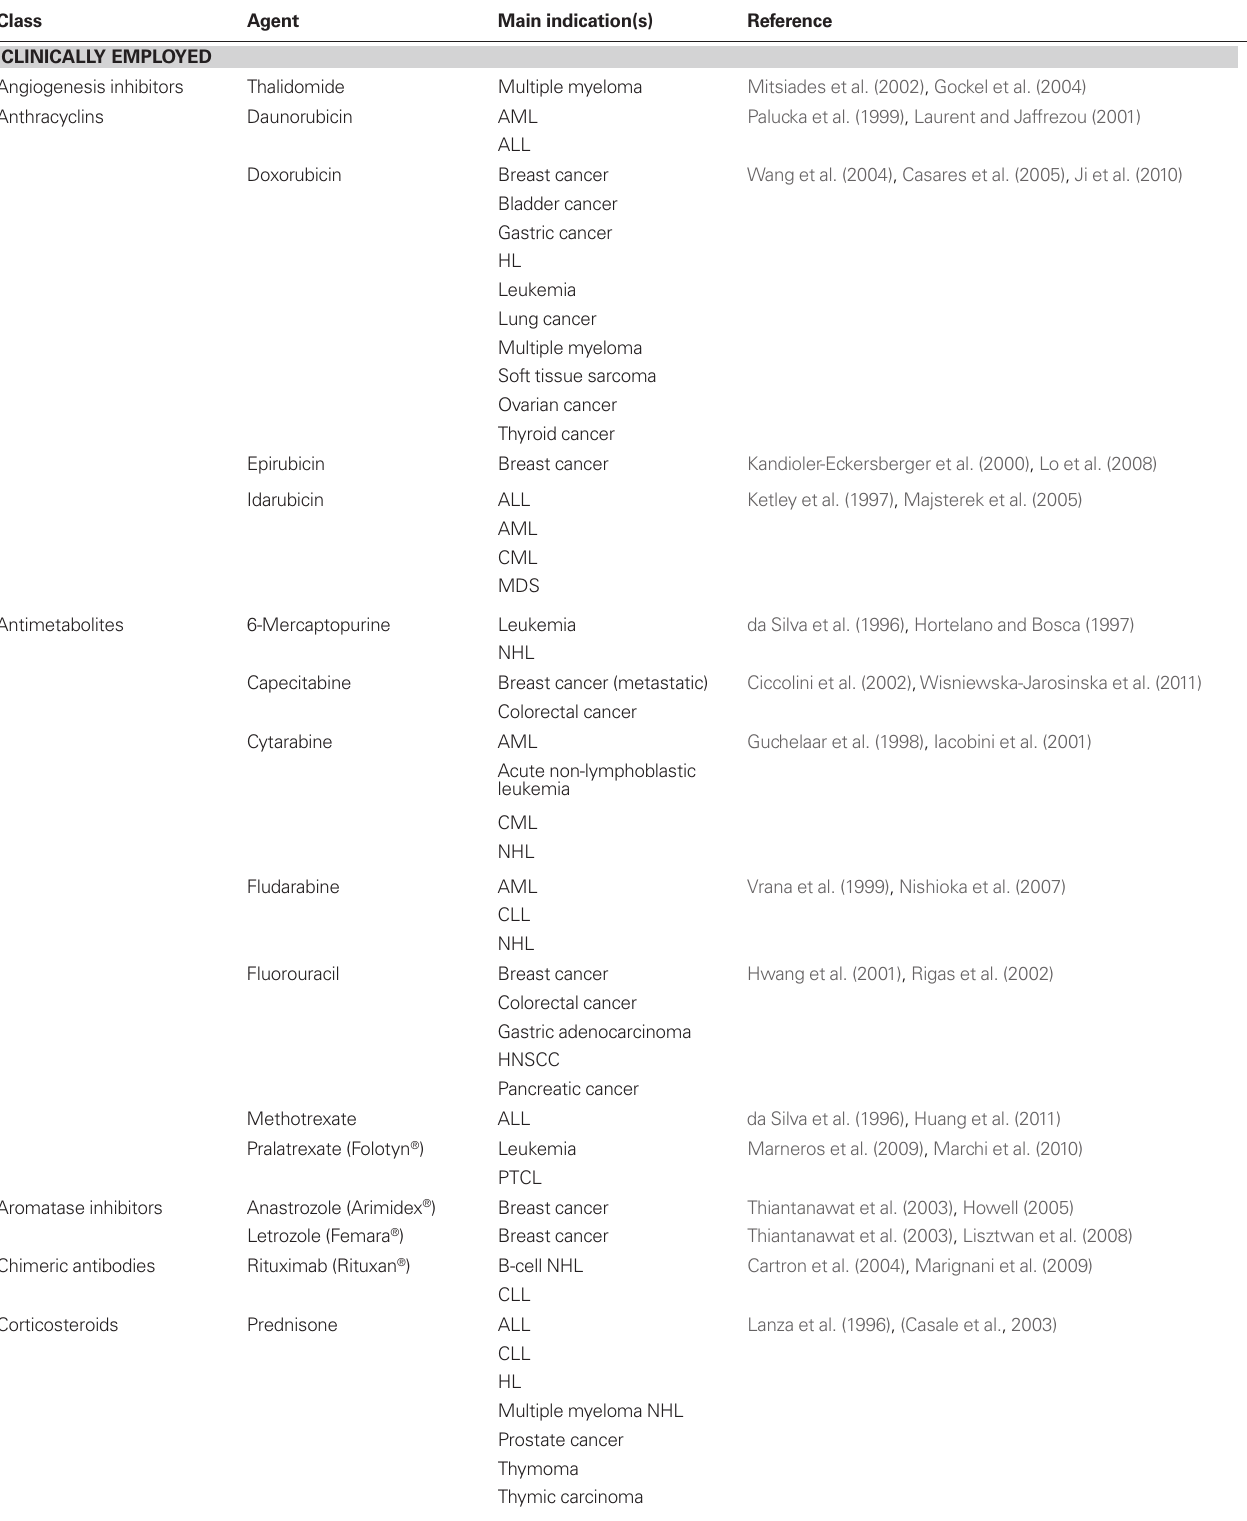
Table 2 | Examples of anticancer agents that operate via